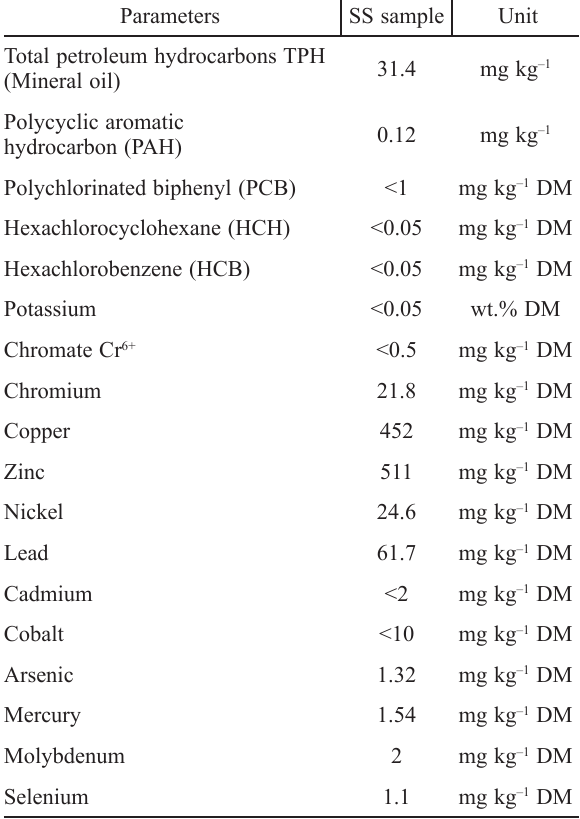
Table 2 – Organic and inorganic pollutants in SS sample Parameters SS sample